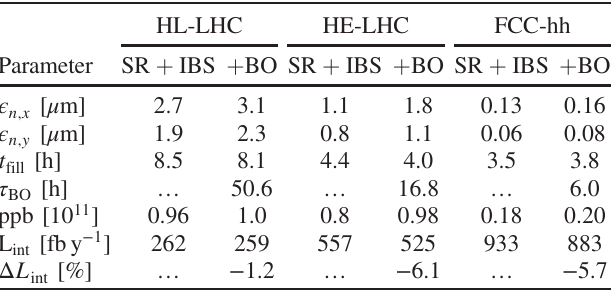
TABLE II. Parameters at the end of a physics fill for HL-LHC, HE-LHC, and FCC-hh, where in one case only the synchrotron radiation damping (SR) and intrabeam scattering growth (IBS) are respected. In the other case emittance growth resulting from burn-off (BO) is added